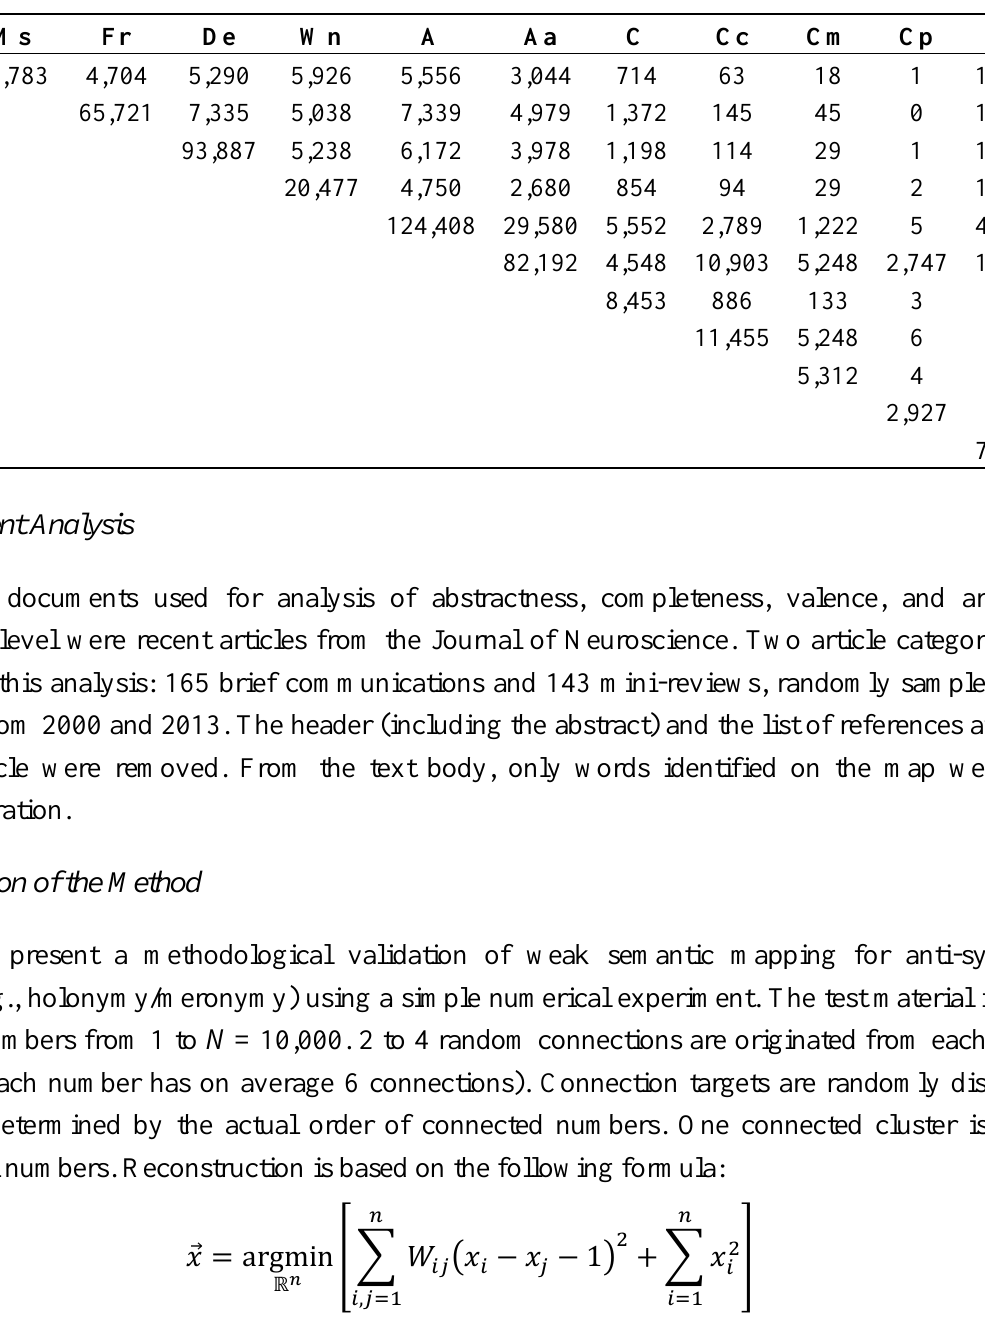
Table 2. Numerical relations among datasets defined in Table 1. The number in each cell is the number of common nodes of the two graphs. Diagonal elements show the total numbers of nodes in each graph, which are also given in Table